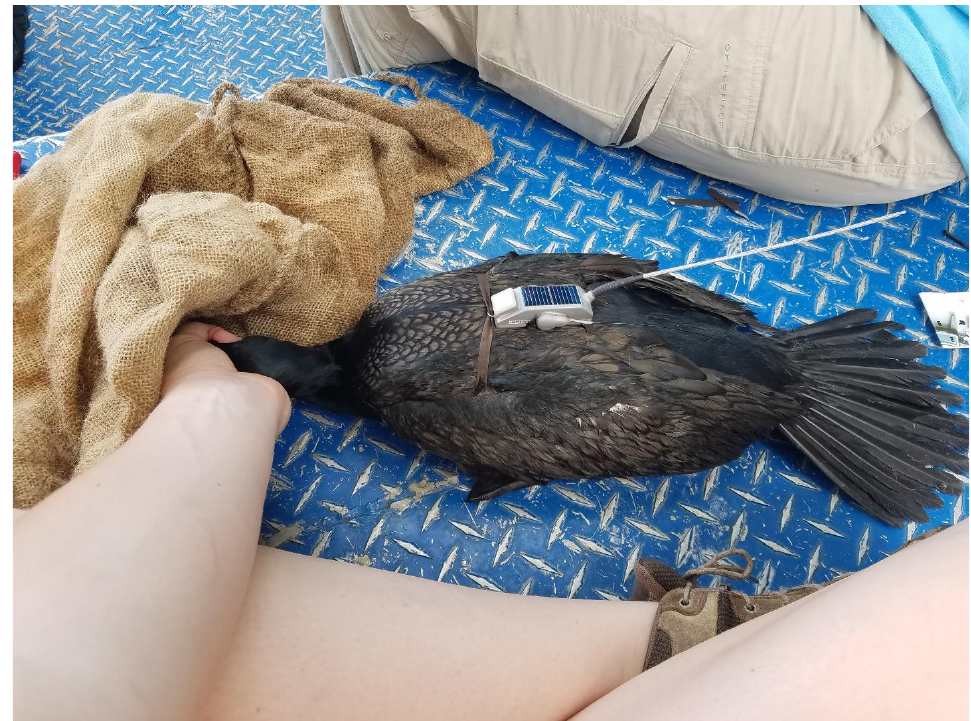
Figure 2. Picture illustrating placement of transmitter on an adult Double-crested Cormorant secured using a Teflon ribbon.